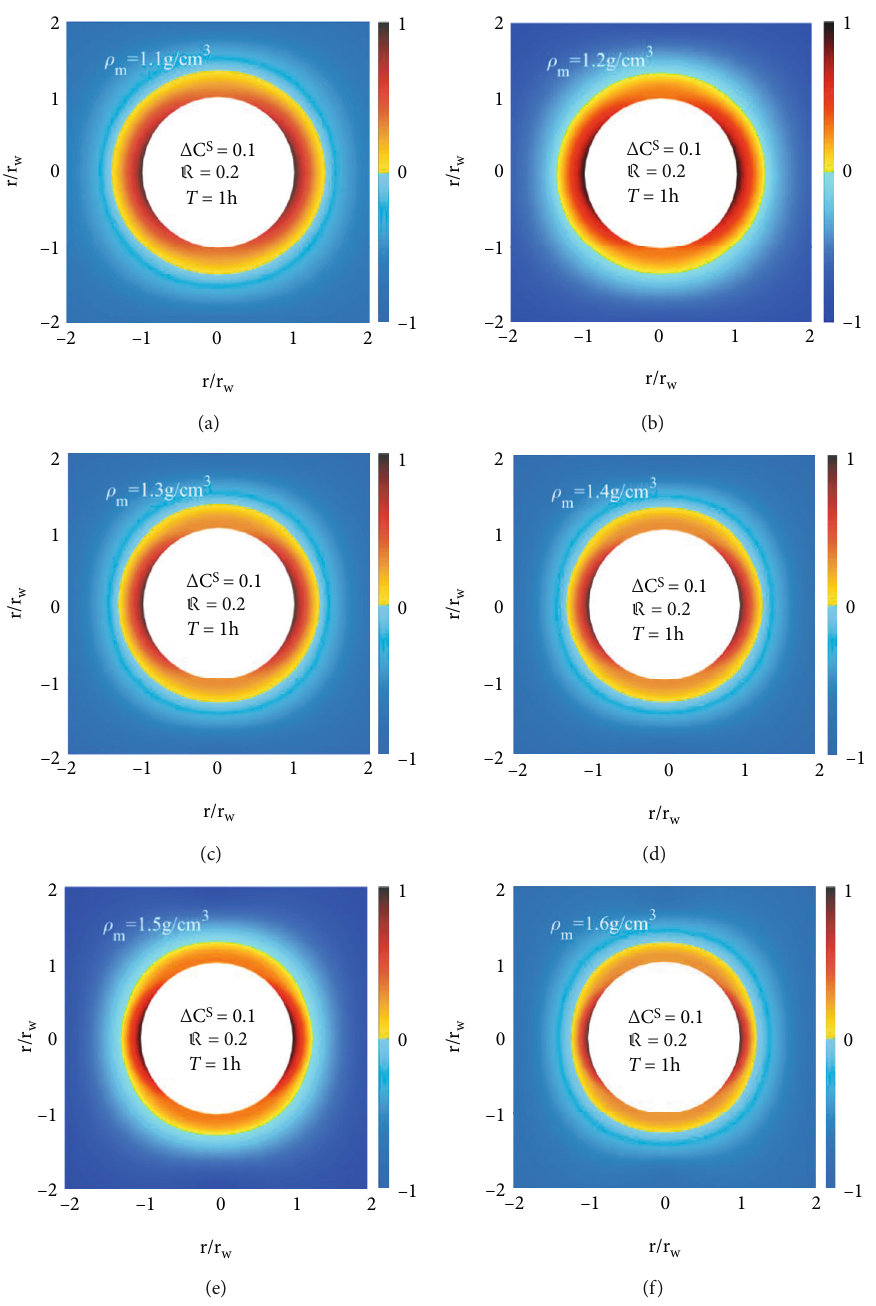
Figure 19: Damage zone around the wellbore of drilled in shallow soft shale for a mud density of (a) 1.1 g/cm 3 , (b) 1.2g/cm 3 , (c) 1.3g/cm 3 , (d) 1.4g/cm 3 , (e) 1.5g/cm 3 , and (f) 1.6g/cm 3